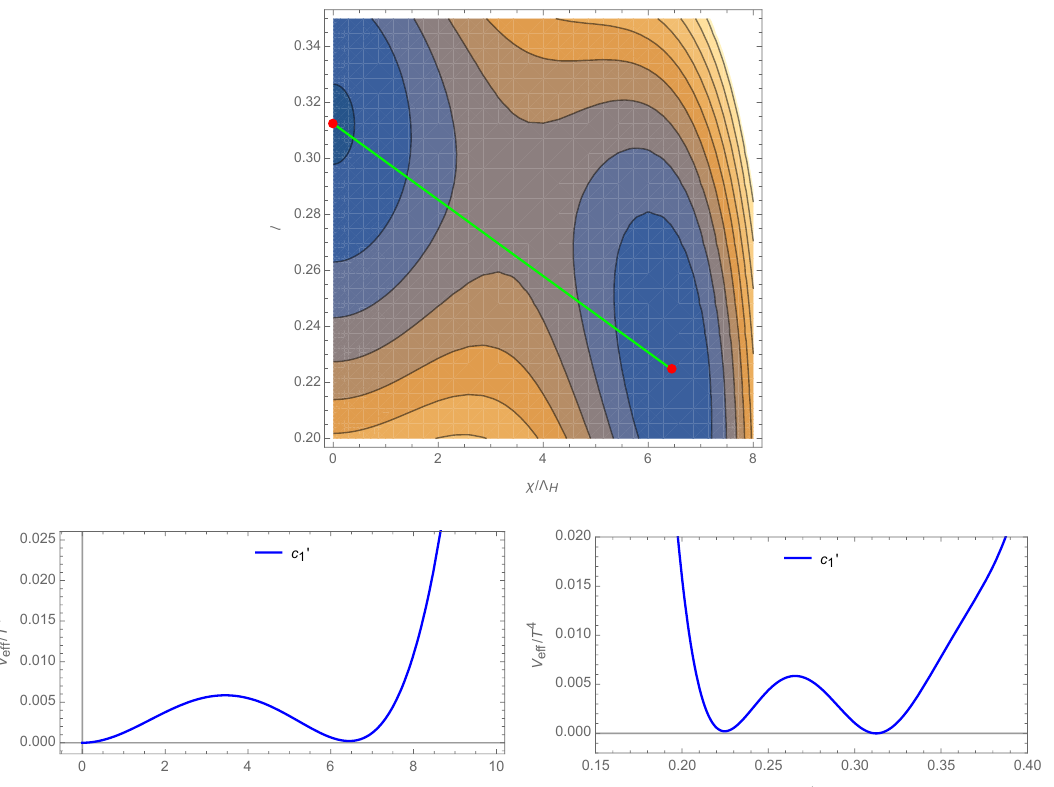
Figure 7 . The potential V e(cid:11) ( L; (cid:31); T ) =T 4 at T c; 3 = (cid:3) H = 14 : 38 as a function of (cid:31) and ‘ . The top panel is a contour plot on (cid:31) { ‘ plane. The green line ( c 0 and (3.61) which are shown by the red points. The bottom panels show the e(cid:11)ective potential along the line c 0 as a function of (cid:31) (left) and ‘ (right). 1